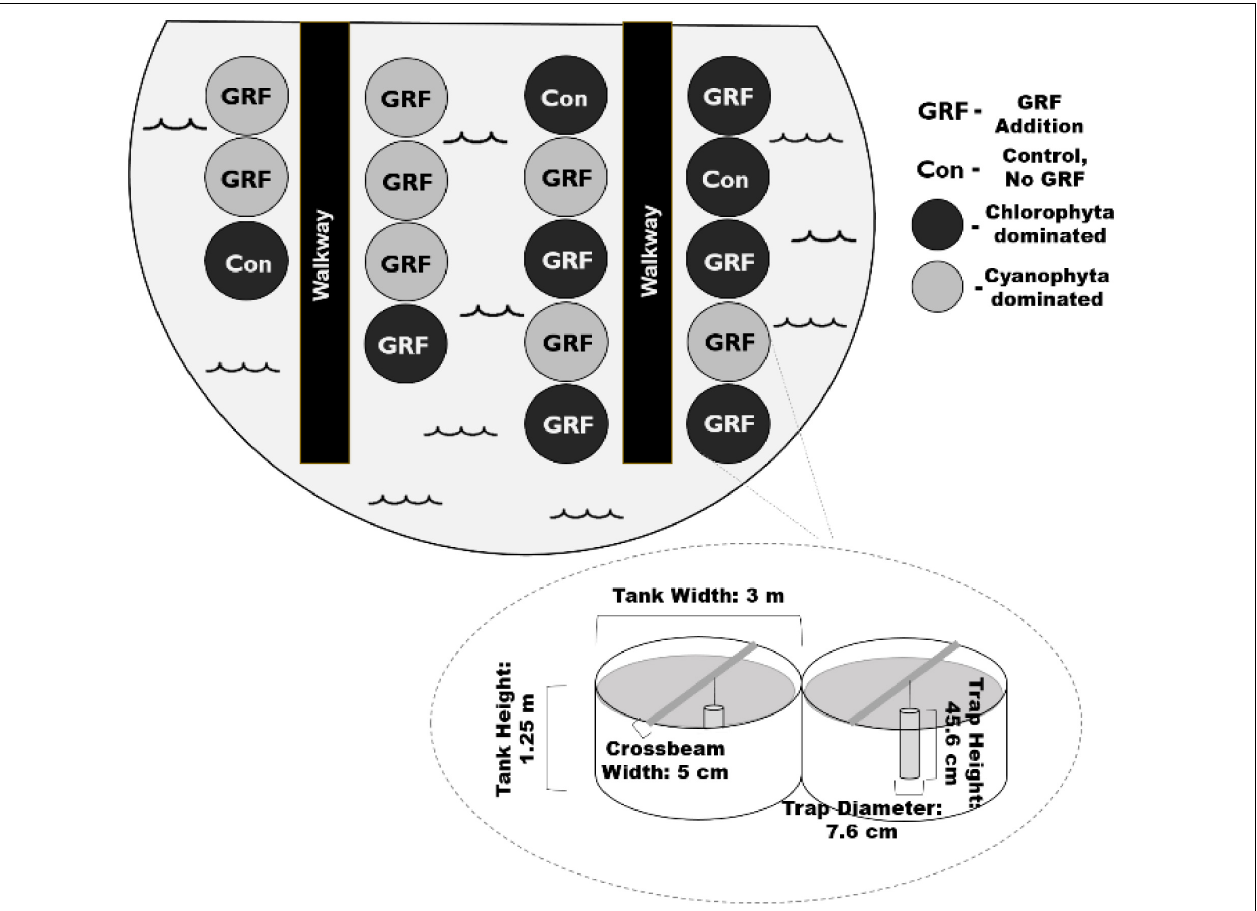
FIGURE 1 | Birds-eye view of mesocosm tank set-up. We added glacial rock flour (GRF) to 14 of the 17 mesocosm tanks used in this experiment. Phytoplankton communities were dominated by either chlorophytes or cyanophytes ( n = 8) at the beginning of the experiment. Of the 9 chlorophyte dominated tanks, a subset ( n = 3) did not receive any nutrient nor GRF amendments and were treated as a control (Con). The remaining chlorophyte dominated tanks ( n = 6) received daily GRF additions. Tanks were kept in a ∼ 1300 m 2 shallow pond that was ∼ 1 m deep to insulate for changes in air temperatures. The pond was surrounded by low vegetation. Mesocosm tanks were ∼ 3 m across, 1.25 m high, and had a volume of 11,000 L. Crossbeams were placed across each mesocosm. Sediment traps were suspended from each